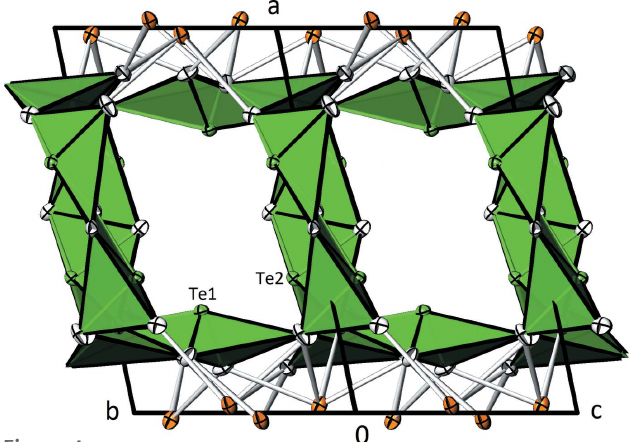
Figure 5 Smaller channels in the (cid:2) -CdTe 2 O 5 structure running parallel to [010]. Displacement ellipsoids are drawn at the 90% probability level.